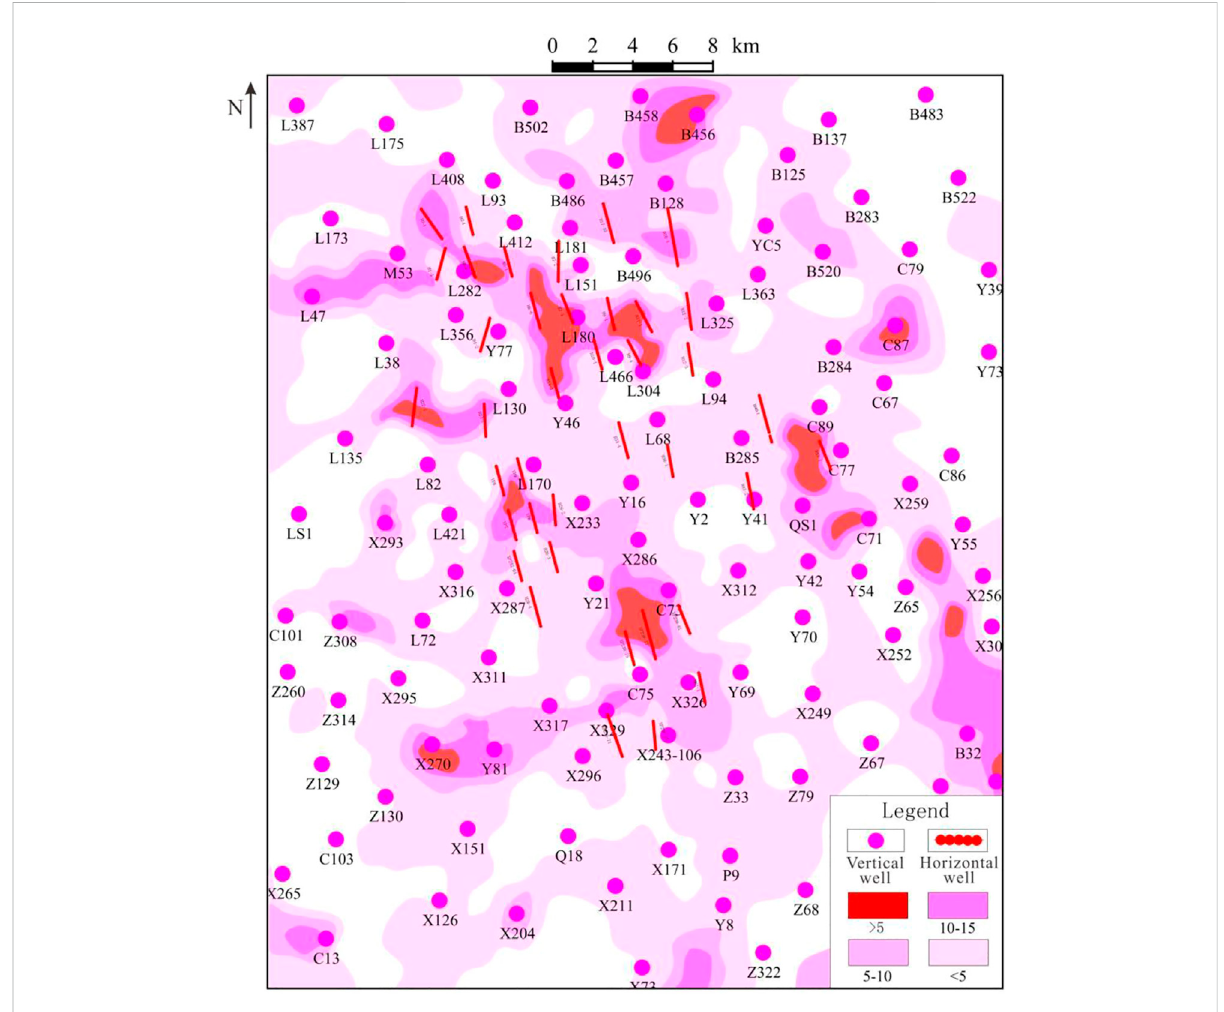
FIGURE 10 Distribution of apparent energy storage coef fi cient of Chang 7 Member in West 233